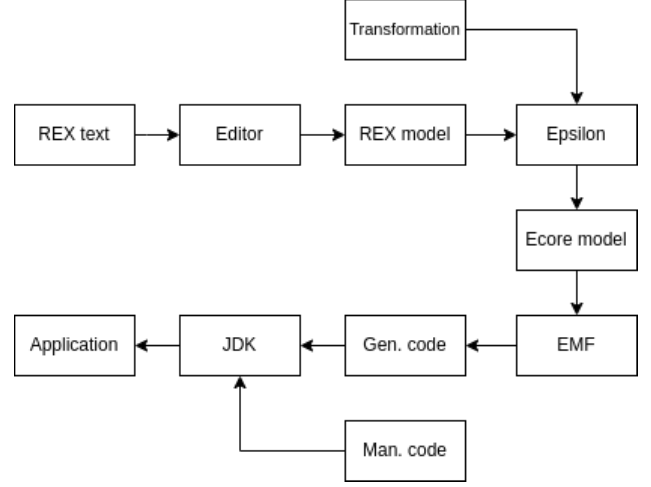
Figure 7. Implementation and usage of REX in